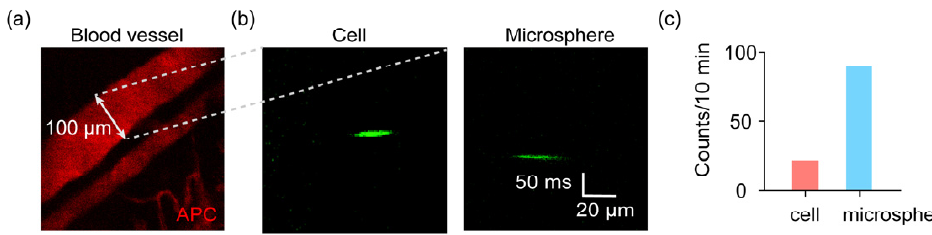
Figure 3. In vivo detection of injected microbeads and cells in live mice. ( a ) The fluorescence image of blood vessels indicated by APC. ( b ) The in vivo images of flowing cells and microbeads in a vein in the ear of a mouse. ( c ) The counts of detected cells and microbeads in a mouse.